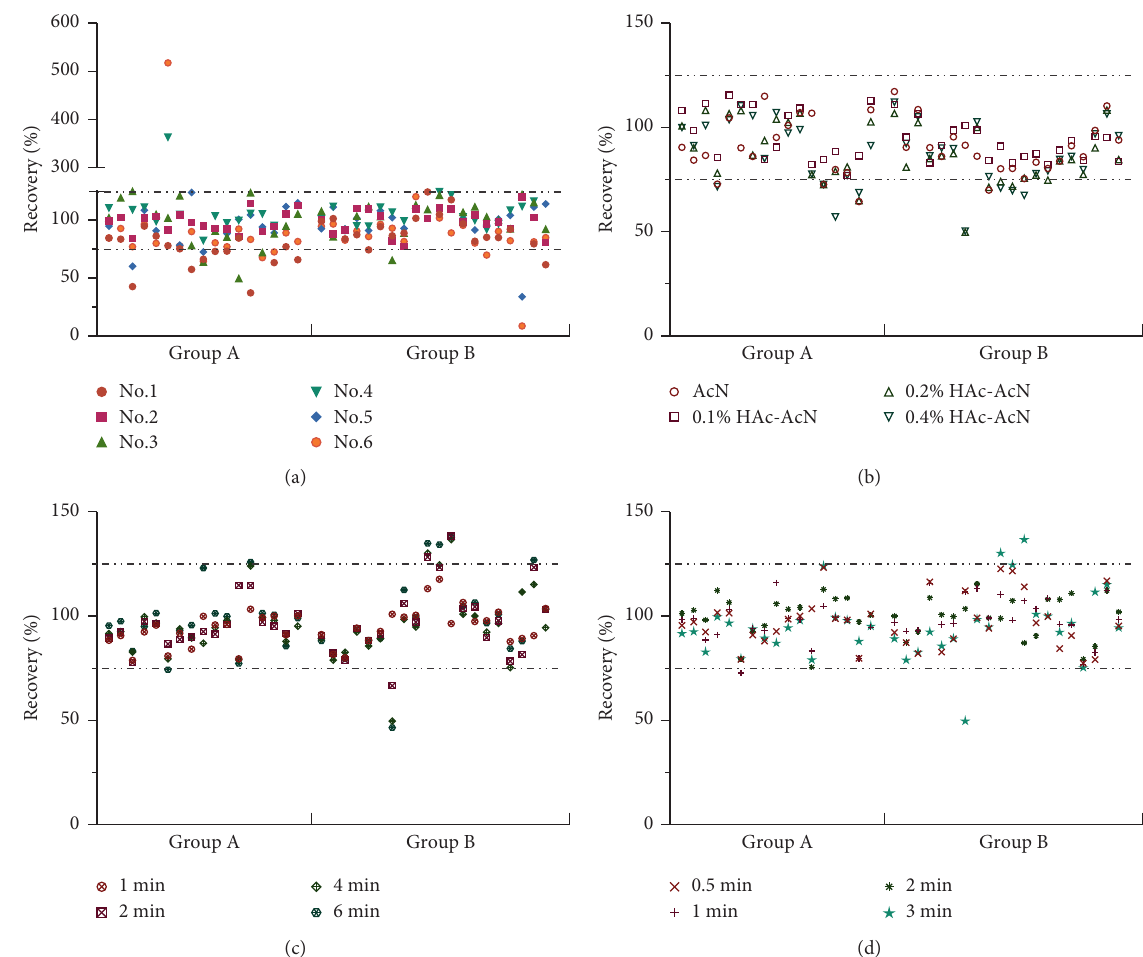
Figure 5: Effect of extraction conditions on pesticide recoveries in groups A and B (a) pesticide recovery for different cleanup sorbents; (b) pesticide recovery for different extraction solvents; (c) pesticide recovery for different extraction times; and (d) pesticide recovery for different purification times.